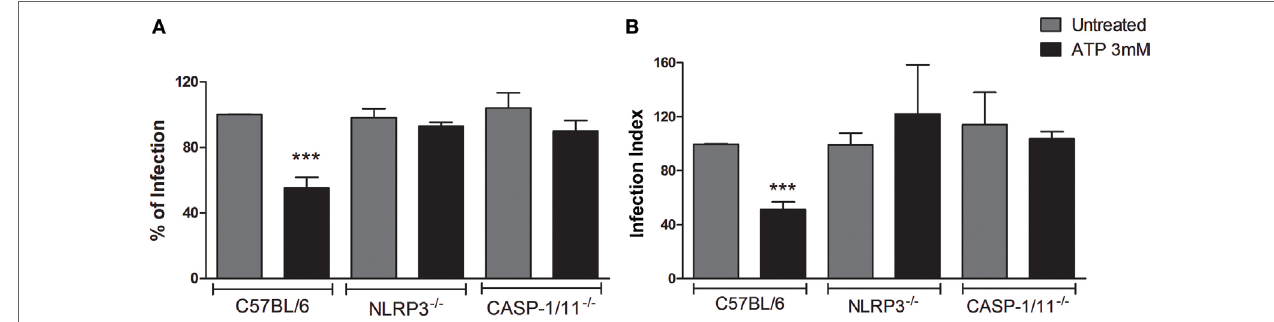
FigUre 1 | Extracellular ATP (eATP)-induced T. gondii control is dependent on NLRP3 and caspase-1/11 molecules. Bone marrow-derived macrophages from C57BL/6 (WT), NLRP3 − / − or Caspase-1/11 − / − mice were infected with T. gondii tachyzoites for 2 h and kept untreated, or were treated with 3 mM eATP for 30 min. Then, cells were incubated at 37°C for a total of 18 h, and stained with Panoptic, for light microscopy quantification of the percentage of infection (a) and the infection index (B) . Treatment with eATP reduced the percentage of infected cells and the infection index in wild-type (C57BL/6) macrophages, but not in the knockout cells. Normalized data represent mean ± SEM of three independent experiments performed in triplicates. *** p ≤ 0.001 vs. untreated (by two-tailed t